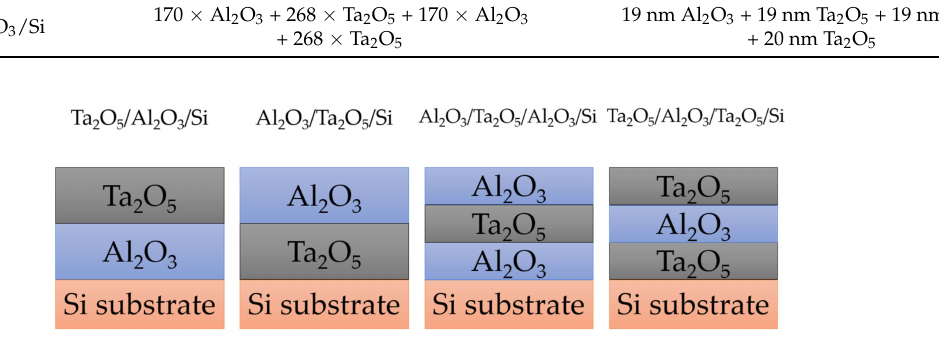
Figure 1. Schematics illustrating the layered structure of the laminates as the notation for each of the laminates is shown